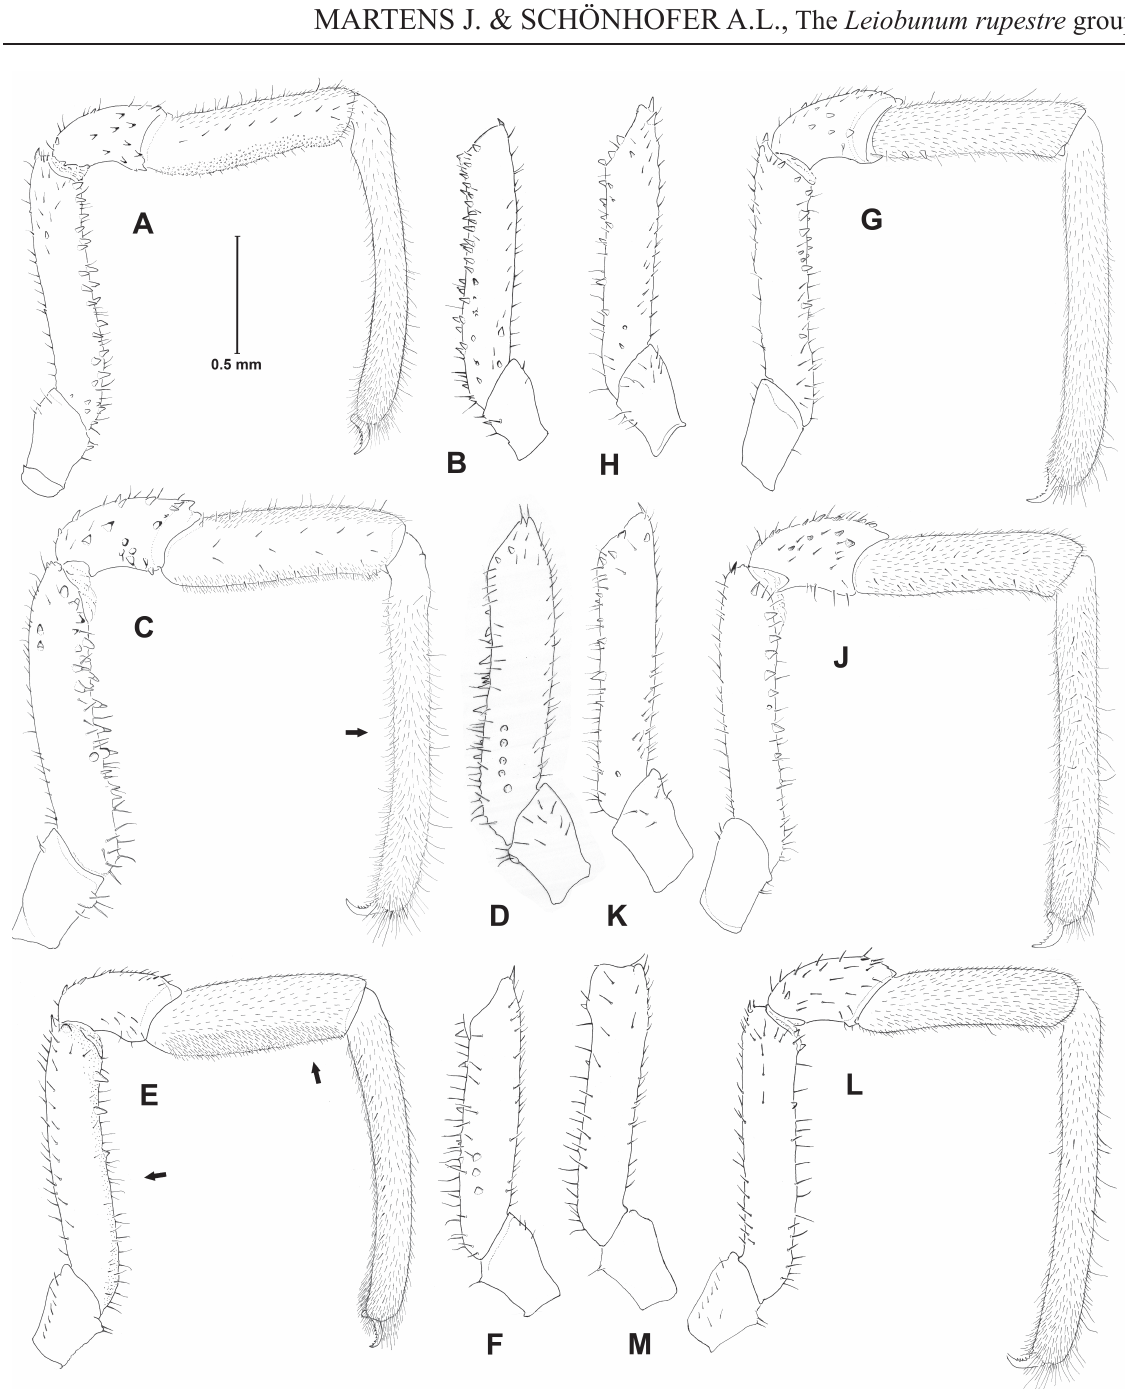
Fig. 4. Pedipalps of the Leiobunum rupestre group, whole pedipalps in lateral view, single femora in medial view. — A–F . ♂♂. A–B . Leiobunum rupestre Herbst, 1799, Germany, Baden-Württemberg,